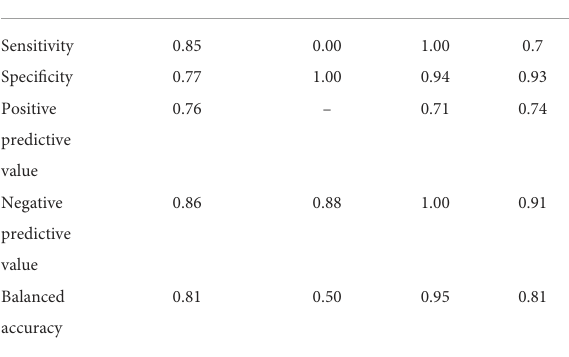
TABLE 5 Confusion matrix that summarizes the performance of the machine learning-based decision tree, giving the number of predicted cases.